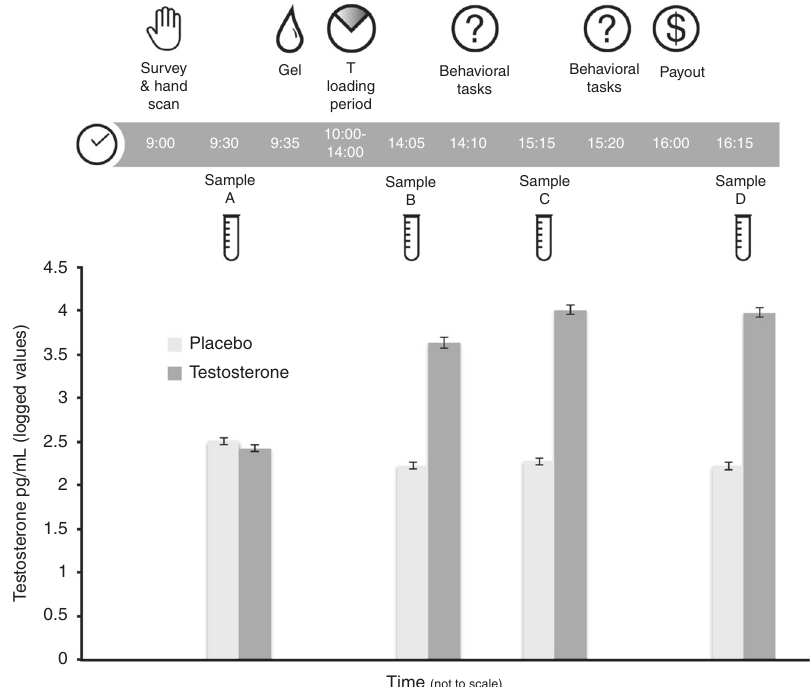
Fig. 1 Experimental setup and salivary testosterone levels. Participants ( N = 243) arrived at the lab at 9:00 a.m., had their hands scanned to take 2D:4D measures, completed an intake survey, and gave a baseline saliva sample ( “ A ” ) before application of either T or placebo topical gel. After a 4-h loading period, participants came back to the lab and took part in a battery of behavioral tasks. Three additional saliva samples ( “ B, ” “ C, ” and “ D ” ) were collected during the experiment, all of which indicated elevated T levels in the treatment group compared to the placebo group. The behavioral tasks reported were the main focus of the study, and took place immediately following the participants ’ return the lab in the afternoon (after saliva sample B). Error bars denote